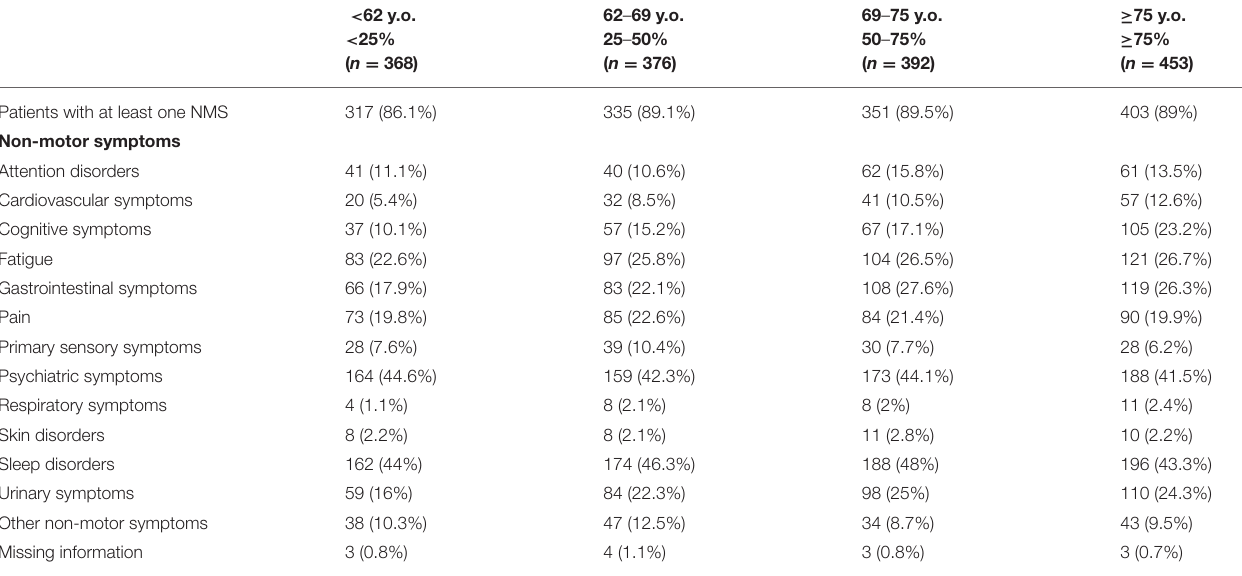
62 – 69 y.o. 25 – 50%